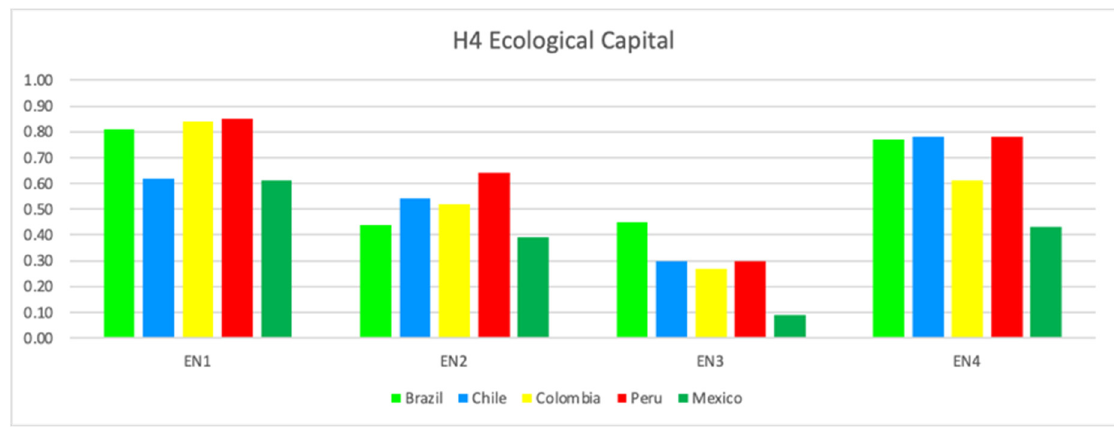
Figure 5. Ecological Capital (EN). Source: Own elaboration based on [45,49,50].